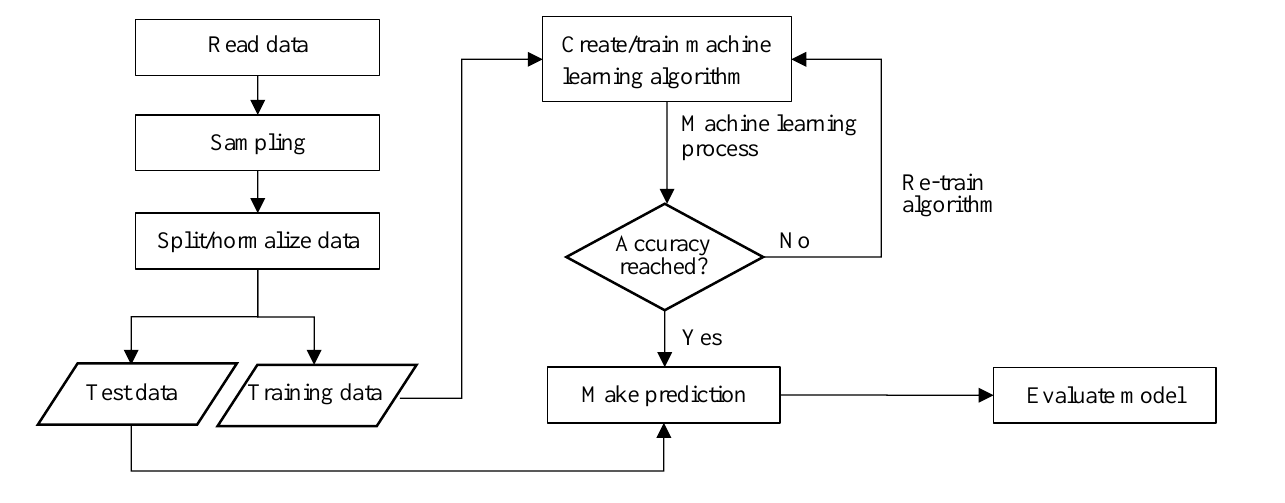
Figure 4. Process flow of the machine learning classification.